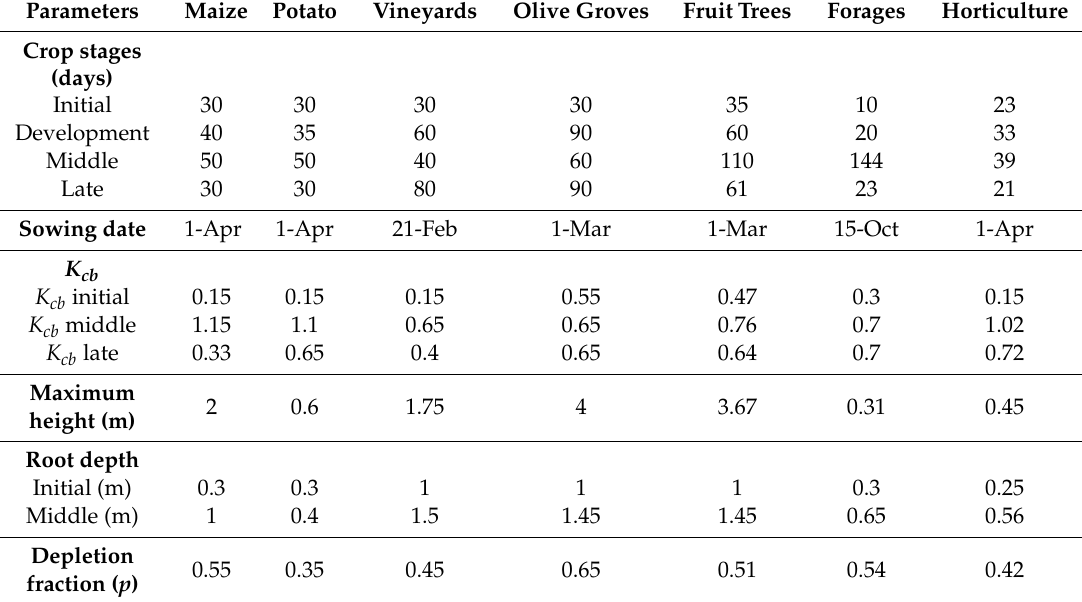
Table 4. Crop parameters of the Sabor River basin that were input into MIKE HYDRO Basin and provided by the FAO tables [54]. The parameters include the crop stages, sowing date, basal crop coe ffi cient ( K cb ), root depth, maximum height, and depletion fraction for each crop. Descriptions of the parameters can be found at http: // www.fao.org /